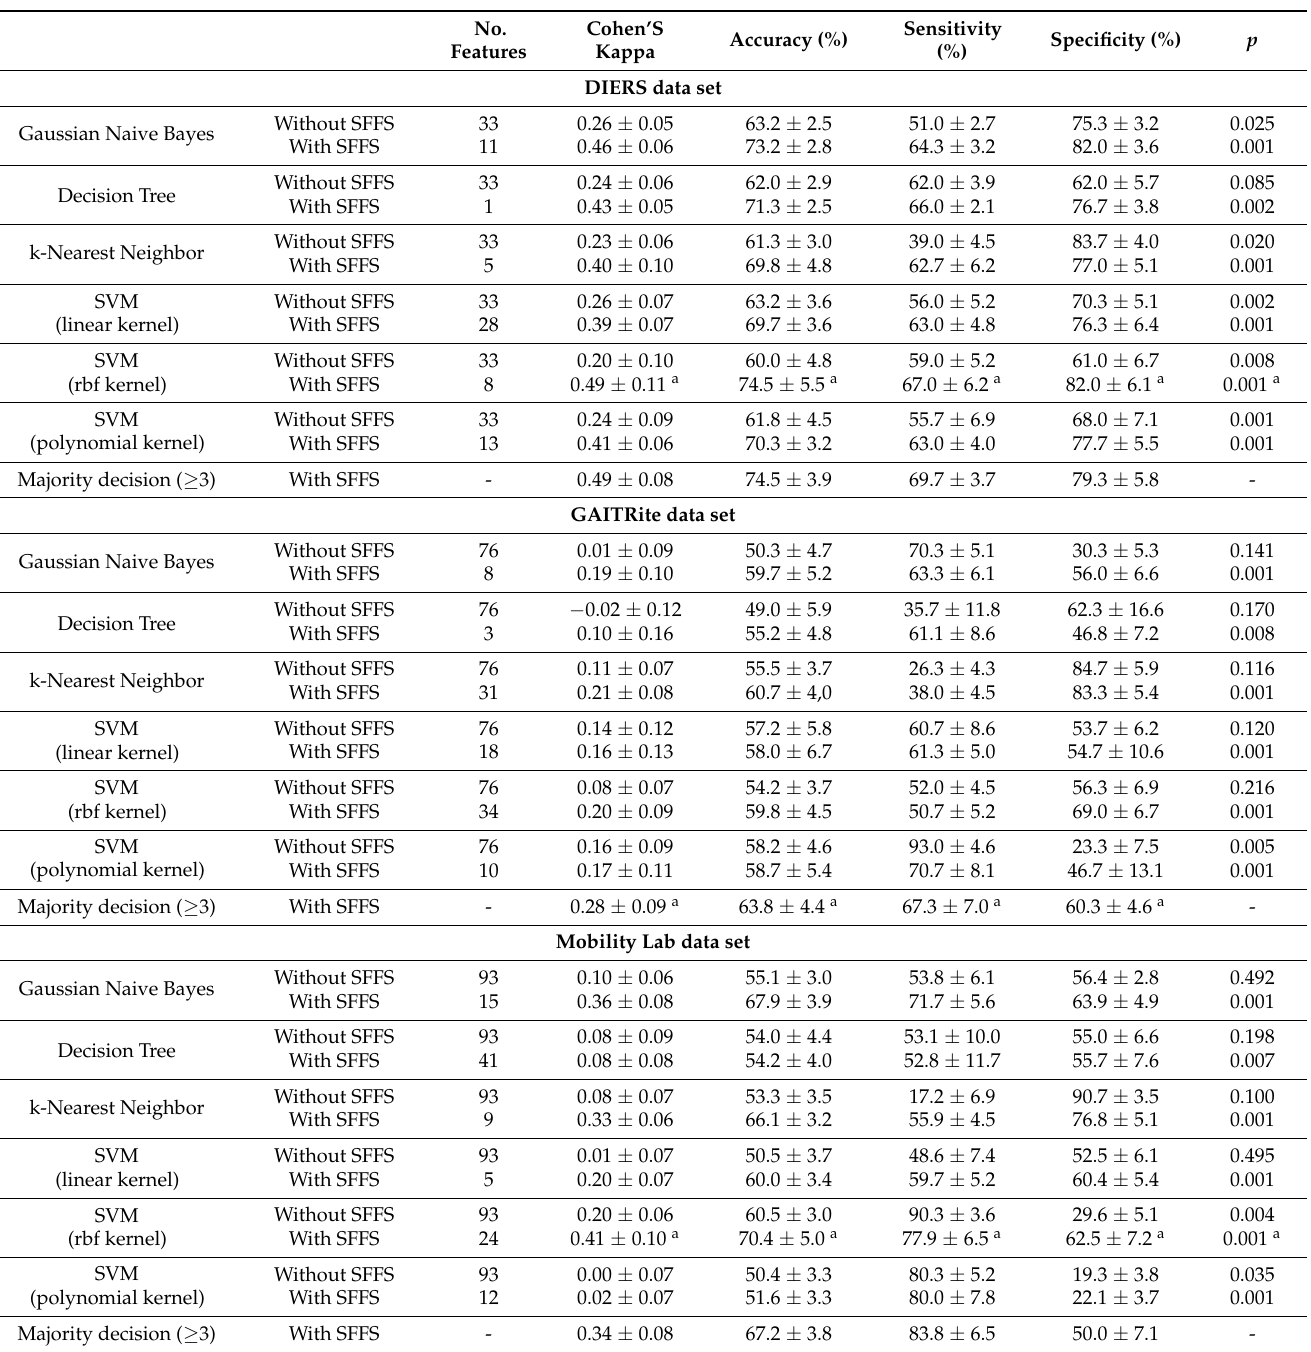
(apart from the Decision Tree) for all three data sets. A compilation of all top-n-relevant features for each individual data set and each classification model is presented in the Appendix A (Table A2). Table 5. Performance of the six classification models on the detection of MS in 60 subjects (matched collective). The values are presented as mean ± standard deviation across 5-fold cross-validation repetition. In addition, the majority decision of all six models is shown. A majority decision for a positive label occurs when at least three models ( ≥ 3) predicted the positive class. a Best overall performance per category for each data set; SVM = Support Vector Machine; rbf = radial basis function; SFFS = sequential forward floating selection; p -value via permutation